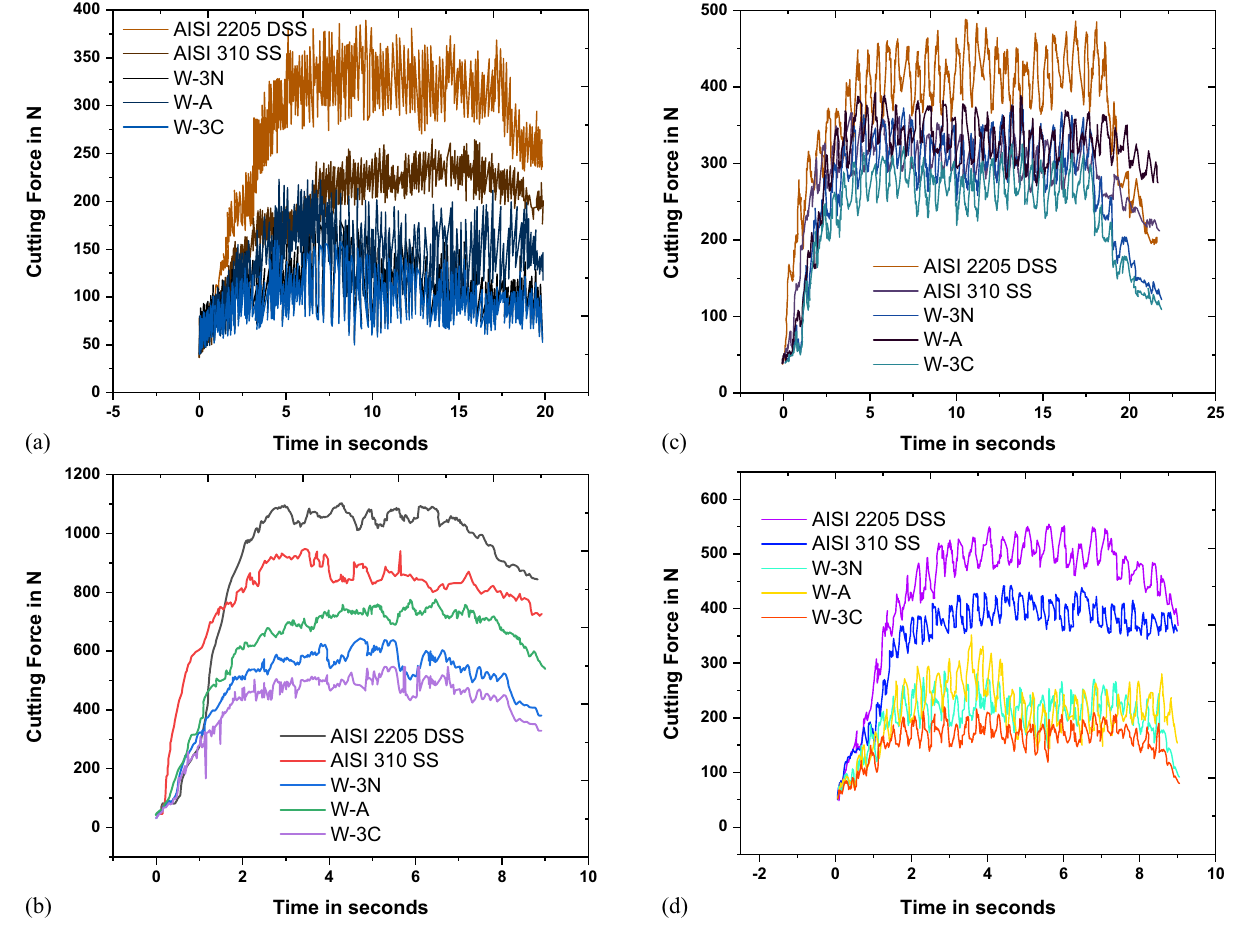
Figure 8: Cutting force pro fi les at drilling parameters ( a ) 600 rpm spindle speed and feed rate of 5 mm · min − 1 , ( b ) 600 rpm spindle speed and feed rate of 10 mm · min − 1 , ( c ) 1,200 rpm spindle speed and feed rate of 5 mm · min − 1 , and ( d ) 1,200 rpm spindle speed and feed rate of 10 mm · min − 1